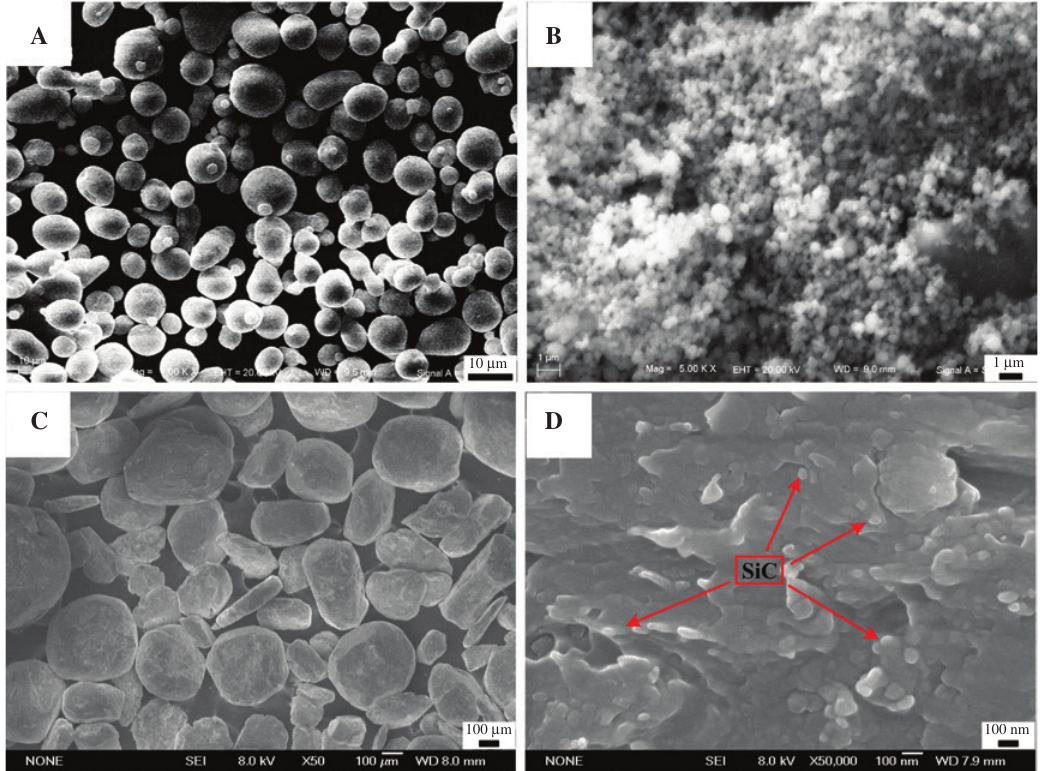
/Al2014 composites particles p